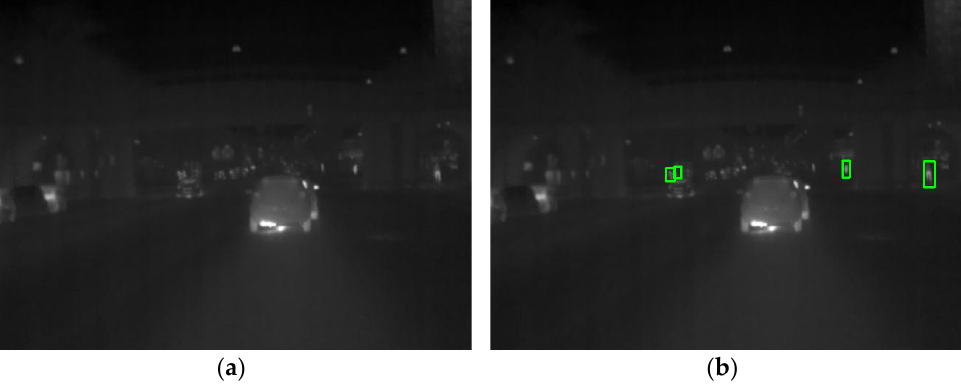
Figure 1. Infrared image instance : ( a ) original infrared image; ( b ) infrared image with